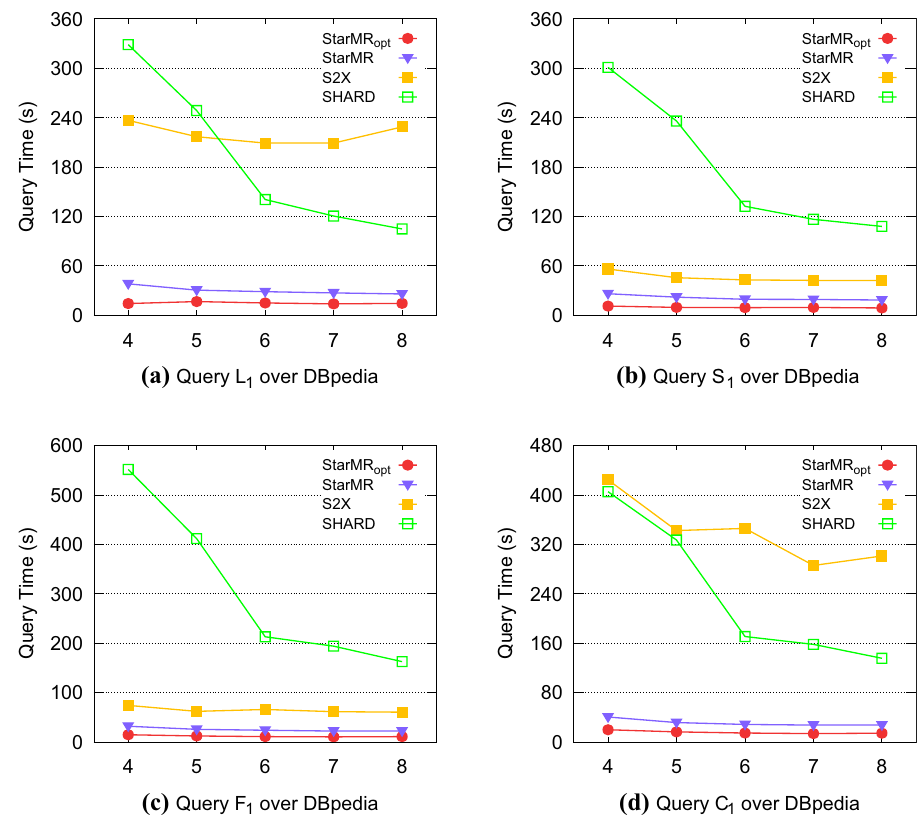
Fig. 12 Scalability on